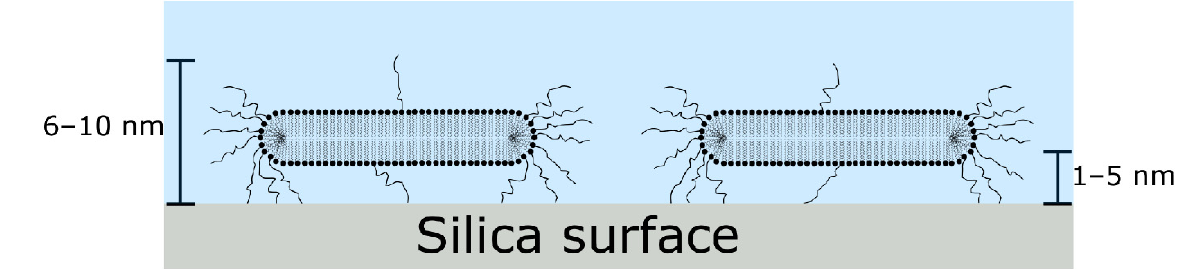
Figure 2. Schematic representation of the proposed arrangement of lipodisks adhered to a silica surface.